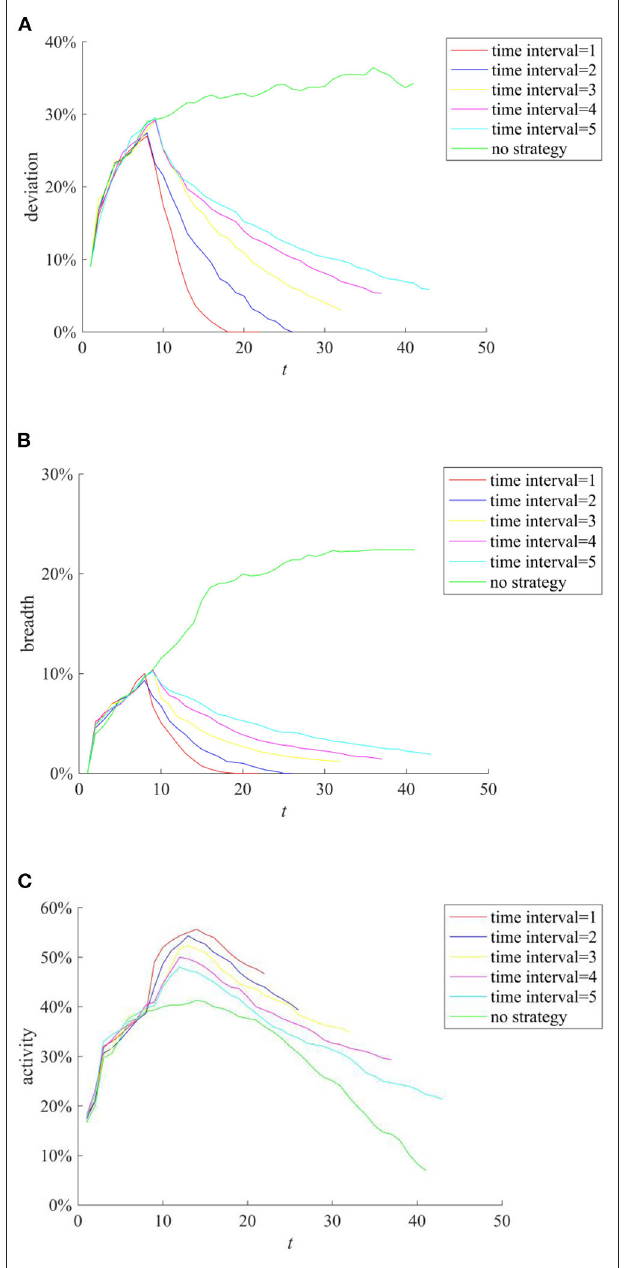
FIGURE 15 | The effect of rumor-refuting strategies based on different rumor-refuting individuals. (A) Information content deviation. (B) Rumor diffusion range. (C) Network activity.